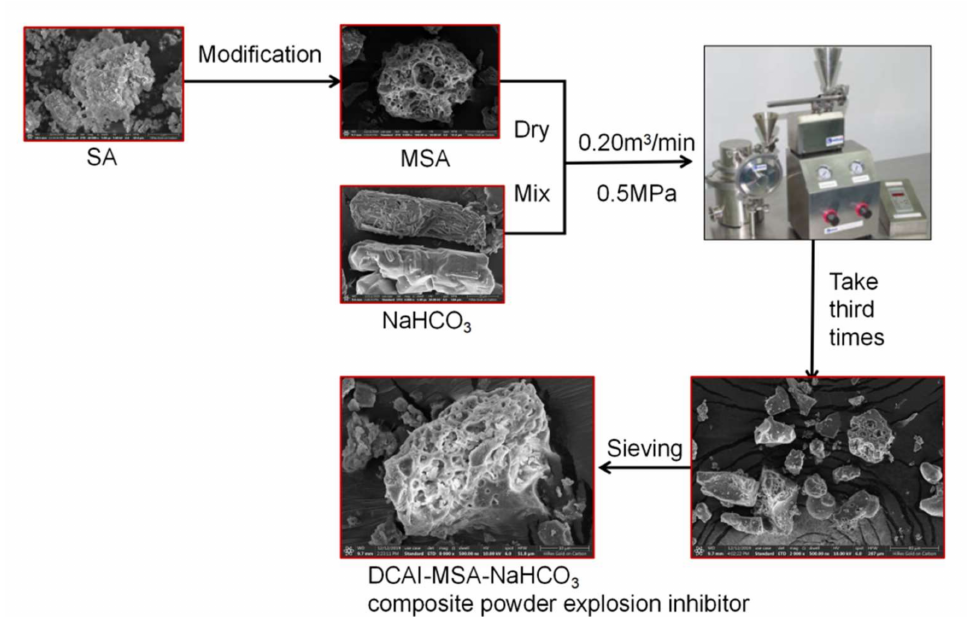
Figure 3. The DCAI compounding